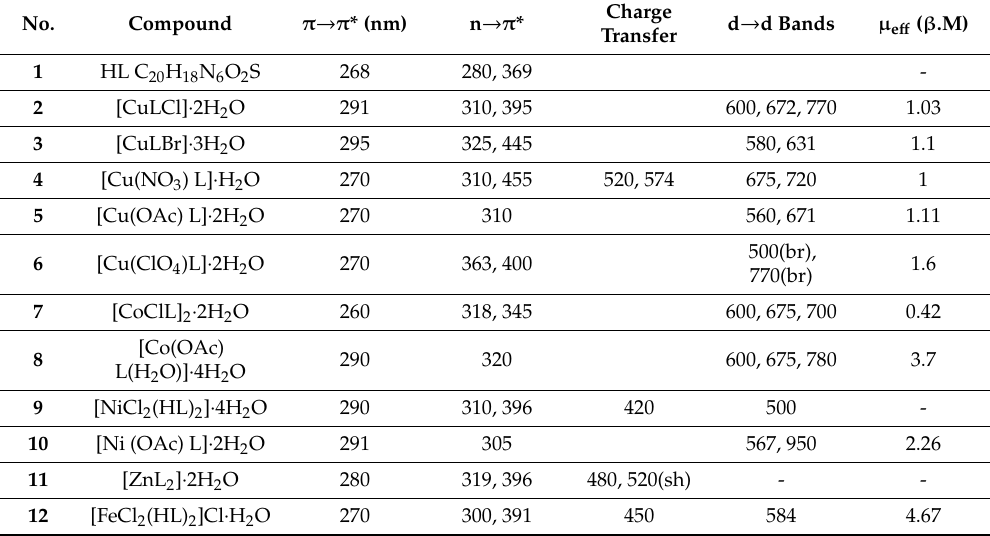
Table 3. The electronic absorption spectral bands (nm) and magnetic moments of ligand 1 and its metal complexes 2 – 12